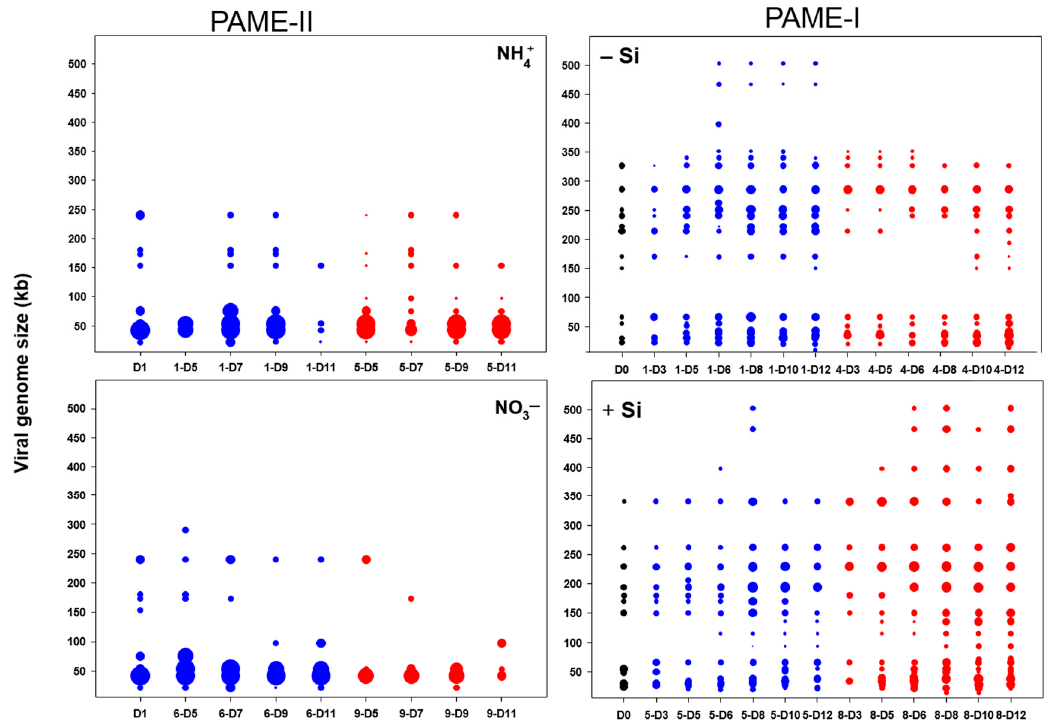
Figure 5. Schematic outline of the PFGE bands sorted by genome size during the mesocosm experiment in PAME-II and PAME-I. D: sampling day. The outline is based on three different electrophoresis runs for each viral sample. Blue circles show samples from treatments with no addition of carbon in the form of glucose, while red circles show samples from treatments with three Redfield additions of carbon. See Figure 2 for more information about experimental design.